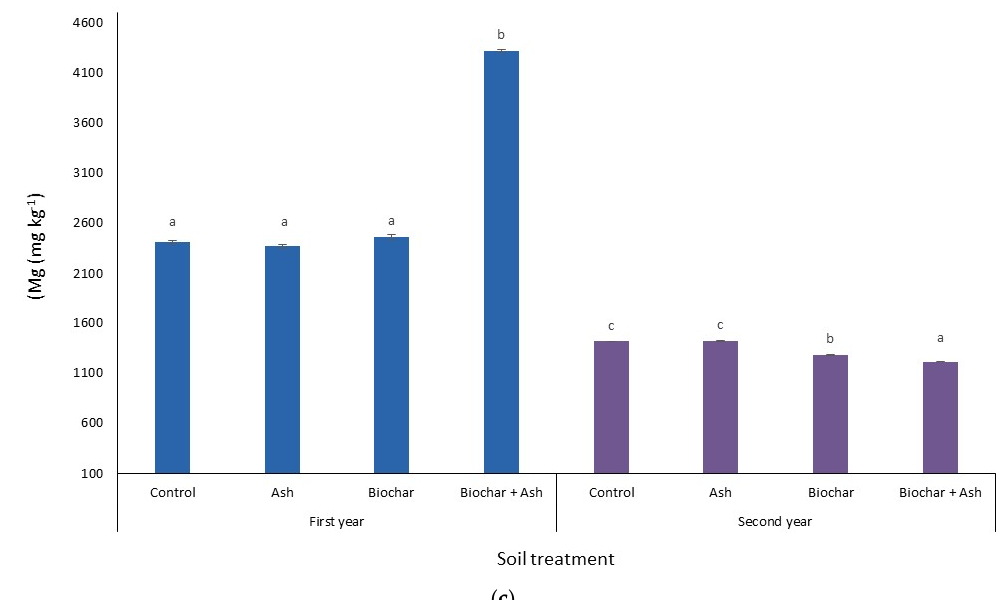
Figure 6. Pyrolysates’ absorbable forms of phosphorus (P 2 O 5 -mg kg −1 ) ( a ), potassium (K 2 O-mg kg −1 ) ( b ) and magnesium (Mg-mg kg −1 ) ( c ) contents, produced from giant miscanthus biomass collected from the control, ash, biochar, and biochar + ash soil treatment plots, one and two years after planting ( n = 12). In accordance with the result of the Bonferroni test, the elements values were not significantly ( α ≤ 0.05) di ff erent among treatments (separate comparison for each